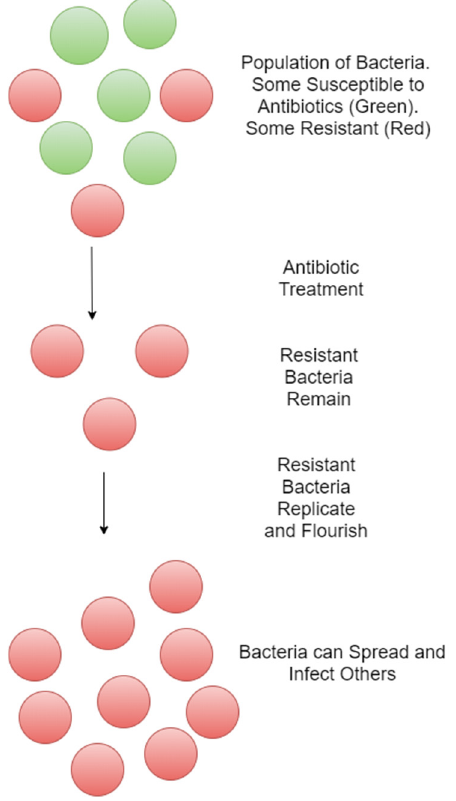
Figure 2. Spread of antibiotic resistant bacteria by natural selection.